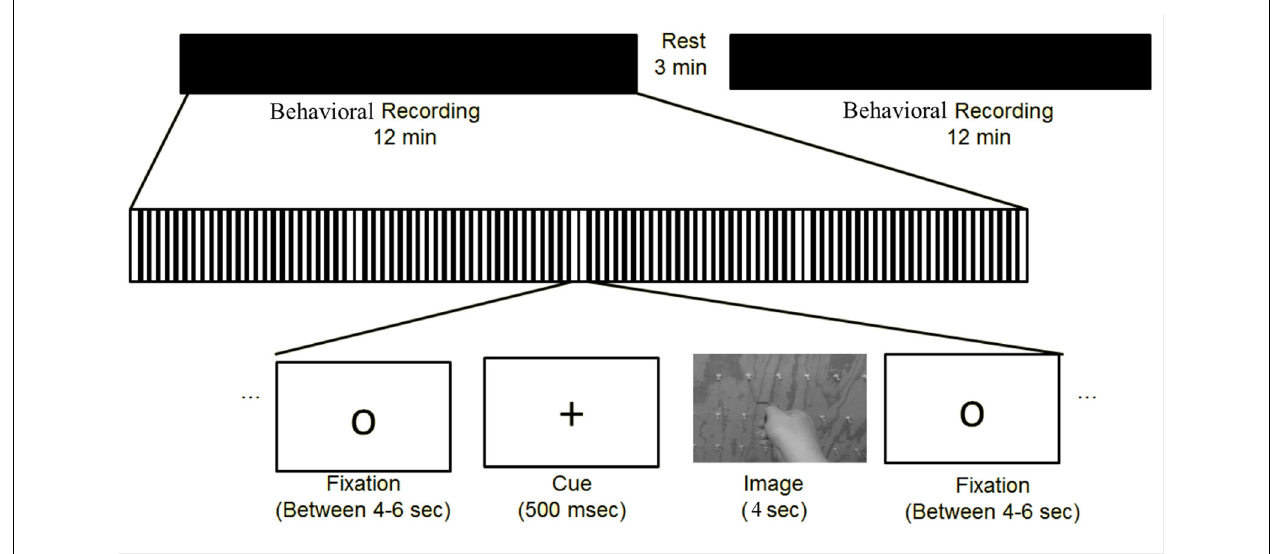
FIGURE 4 | Depicts the event-related experimental design of the